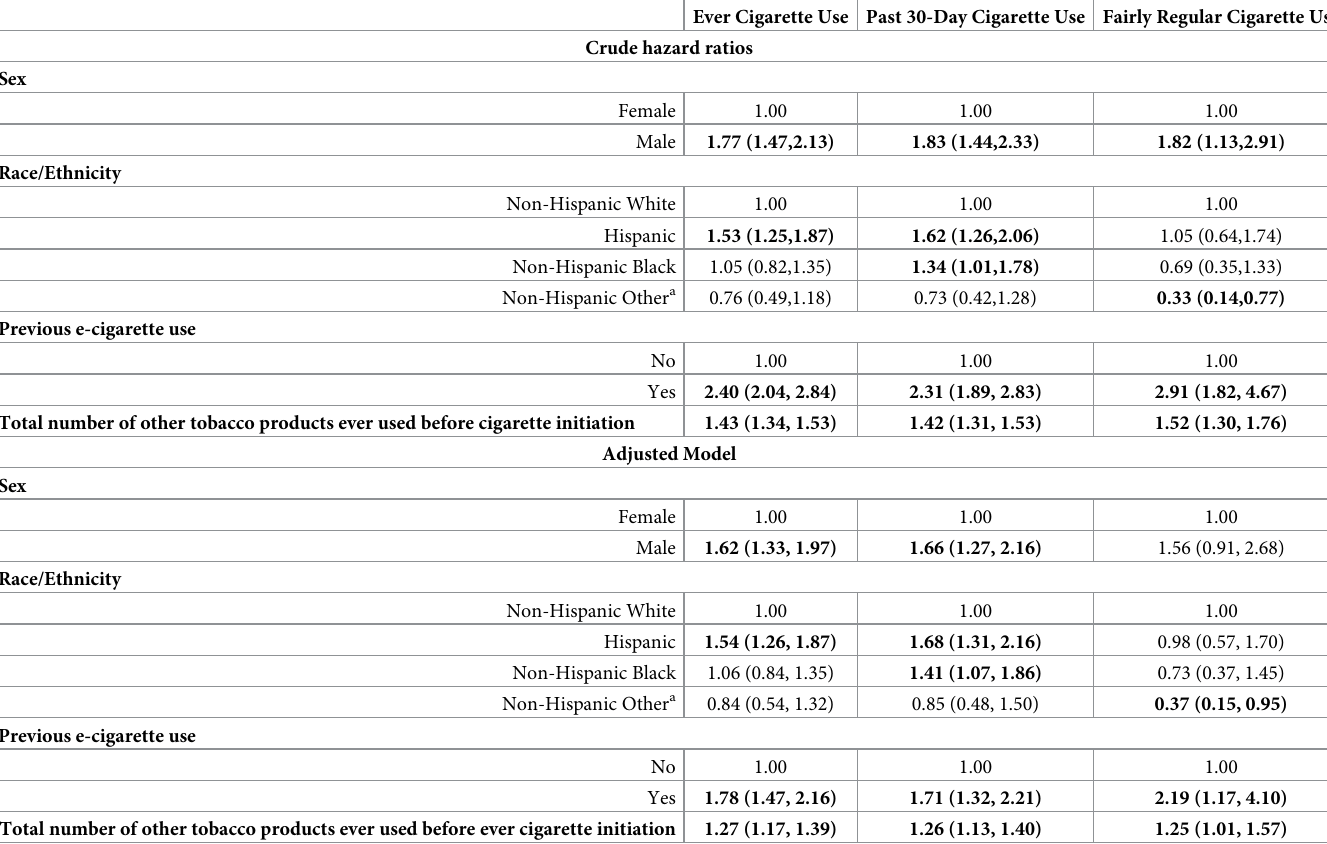
Table 3. Crude and adjusted hazard ratios (95% Confidence Intervals) for age of initiation of cigarette